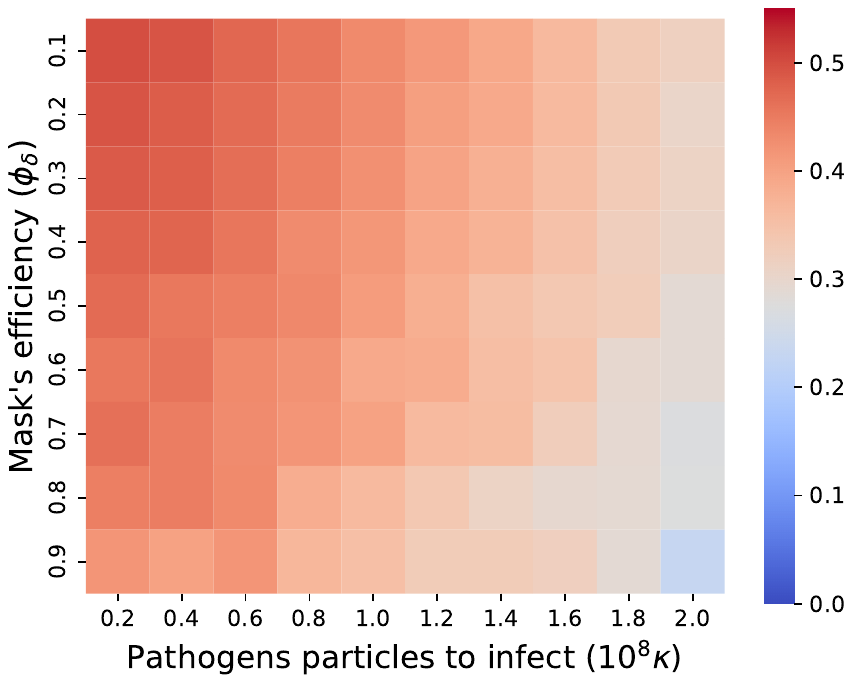
Figure 6. A sensitivity analysis of the infection rate as a function of the mask’s efficiency and the number of pathogens needed to infect an individual. The results are shown as the average value of all the rooms in Table 2 with 10 realisations